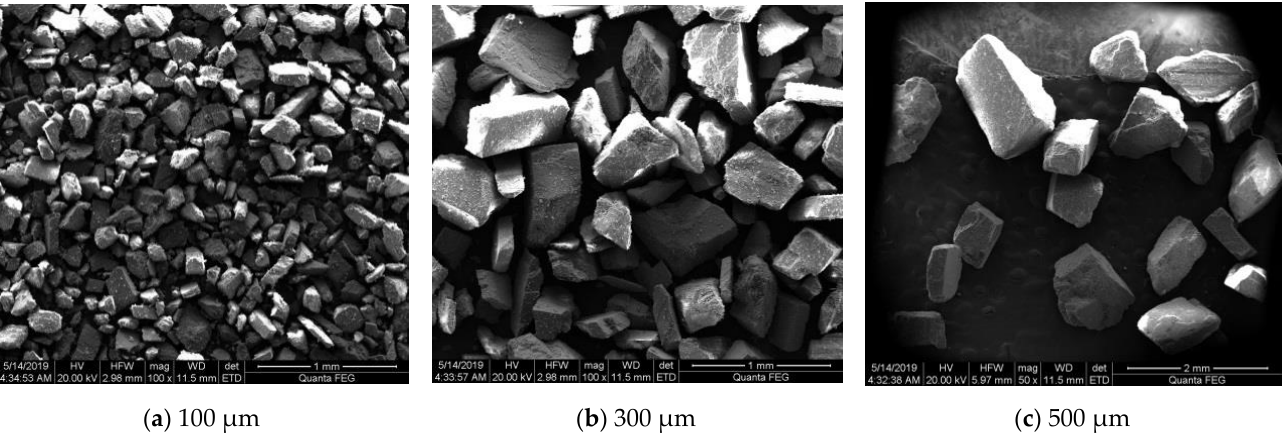
Figure 3. The scanning electron microscopy (SEM) images of different particle sizes. ( a ) Quartz sand with a particle diameter of 100 μm. ( b ) Quartz sand with a particle diameter of 300 μm. ( c ) Quartz sand with a particle diameter of 500 μm.